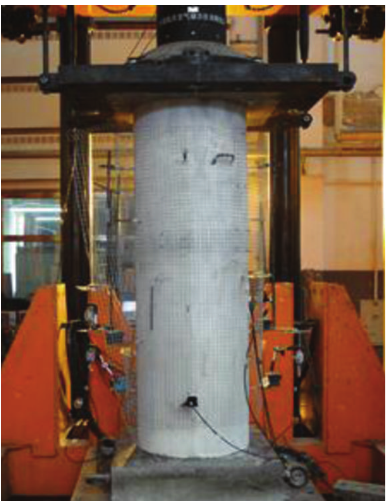
Figure 11: Loading and measuring instruments.